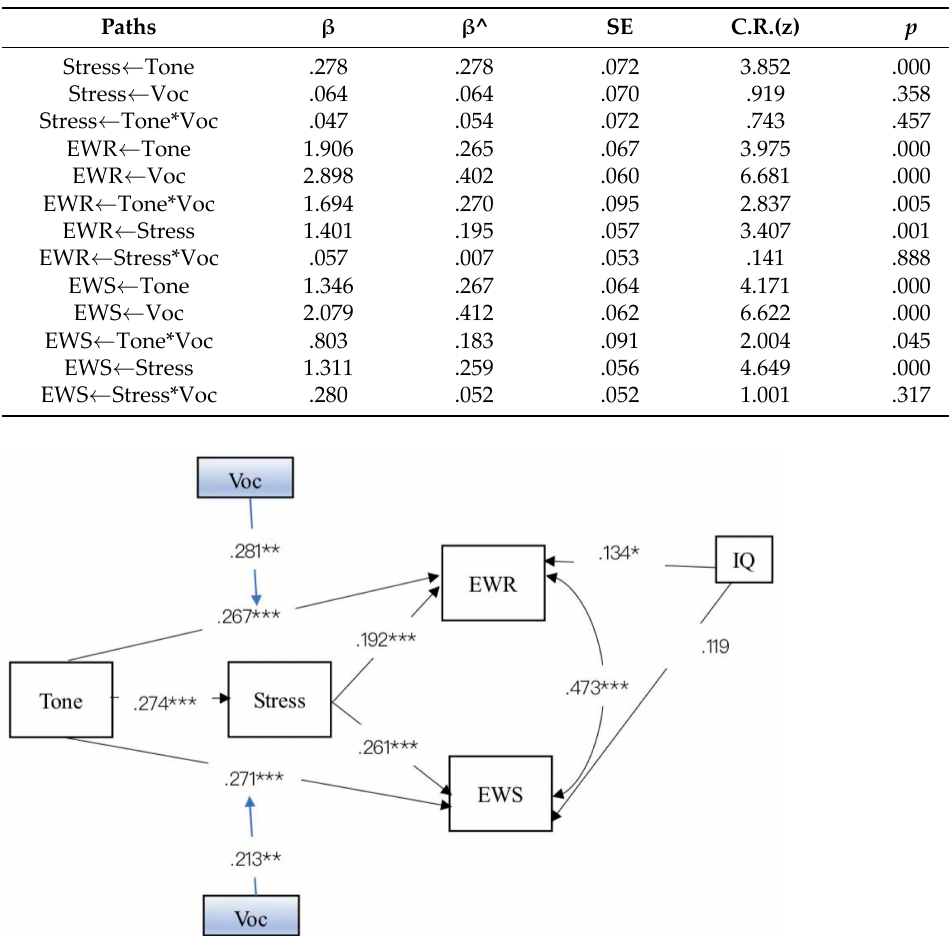
Figure 3. The moderated mediation model of tone, stress, vocabulary, and English word‑level liter‑ acy with standardized factor loadings. Solid lines represent statistically significant relations whereas dashed lines represent nonsignificant relations. * p < .05, ** p < .01, *** p < .001. Table 5. Moderated Structural Equation Modeling: Effects of Tone, Stress, Vocabulary, Tone*Stress Interaction, Stress*Vocabulary Interaction on English Word Reading and Spelling Performance.